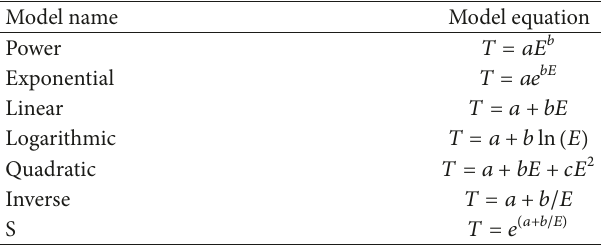
Table 1: Mathematical models applied to the thawing time curve.